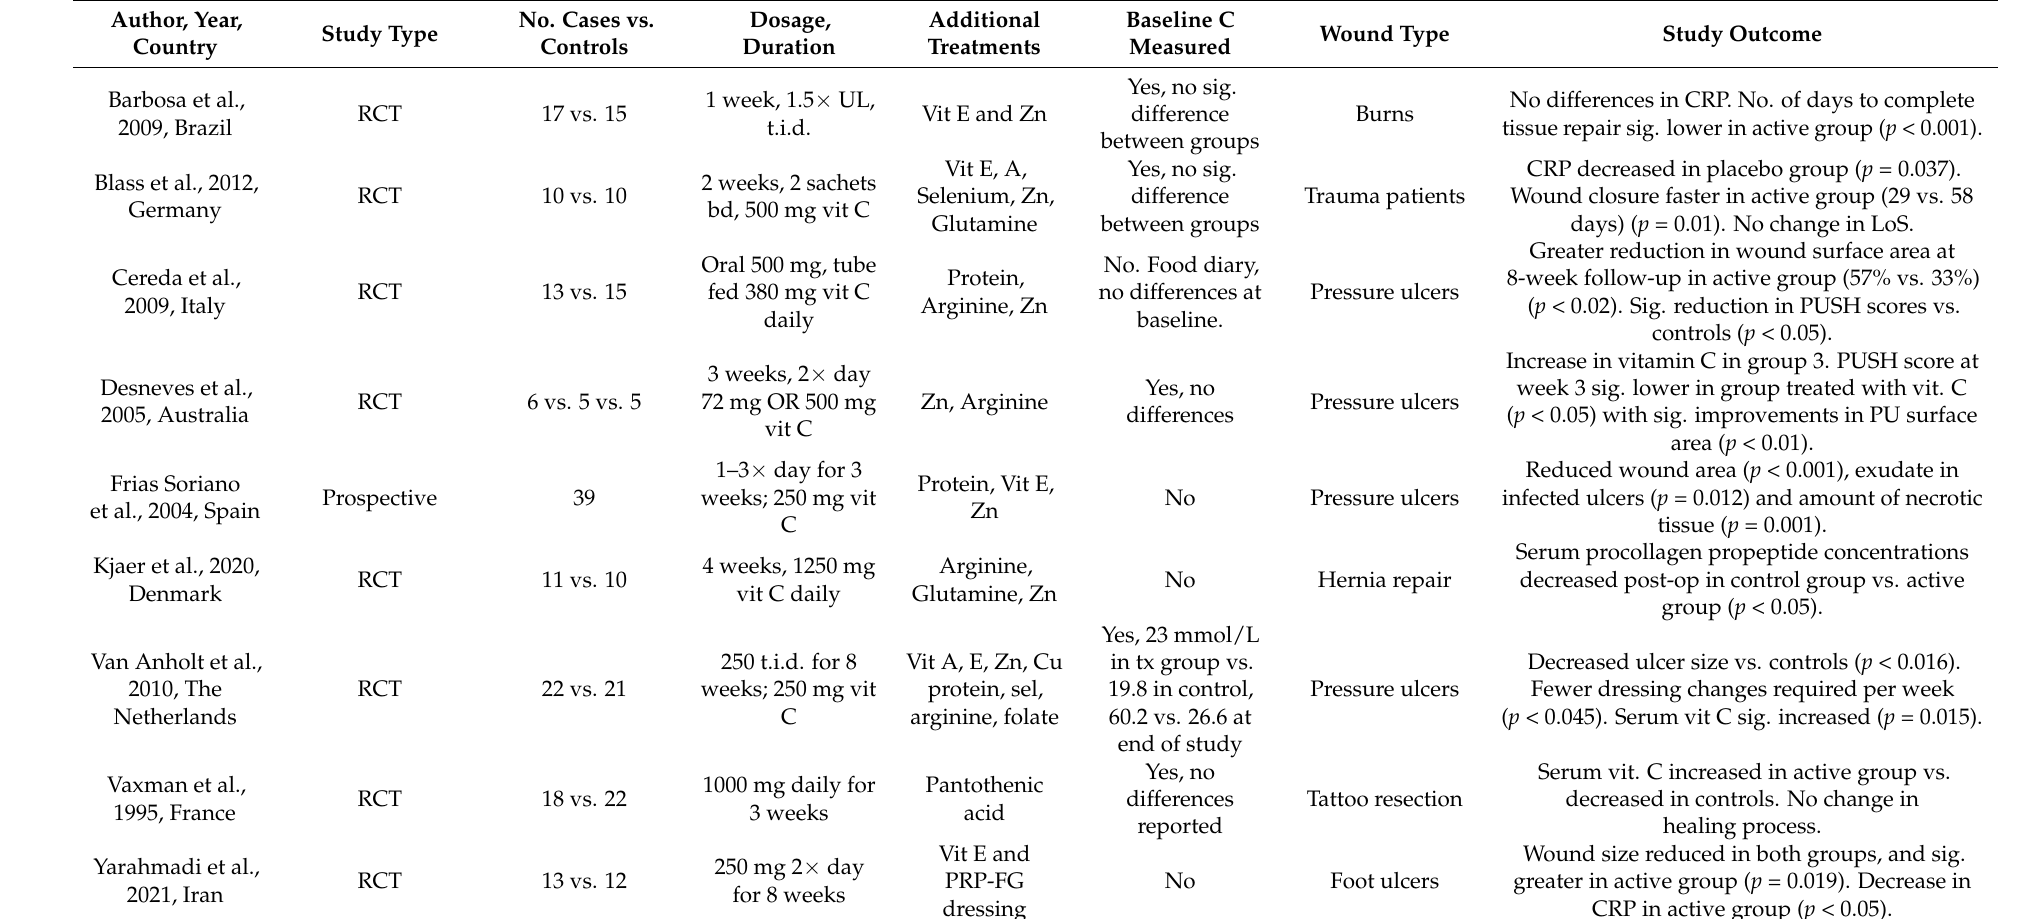
Table 3. Studies with Combined